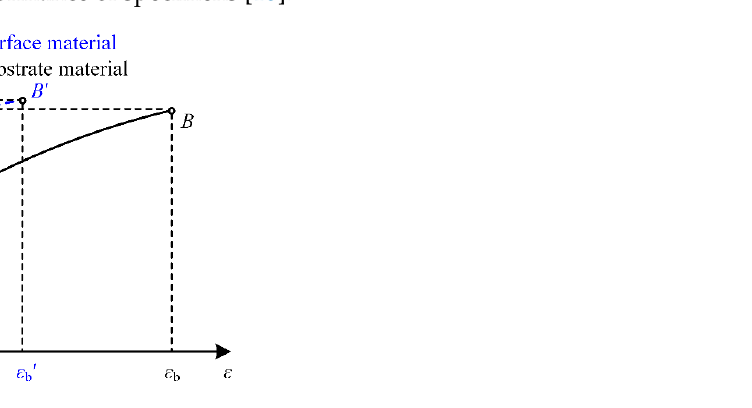
Figure 2. Schematic diagram of the mechanical properties of materials with plastic deformed sur-